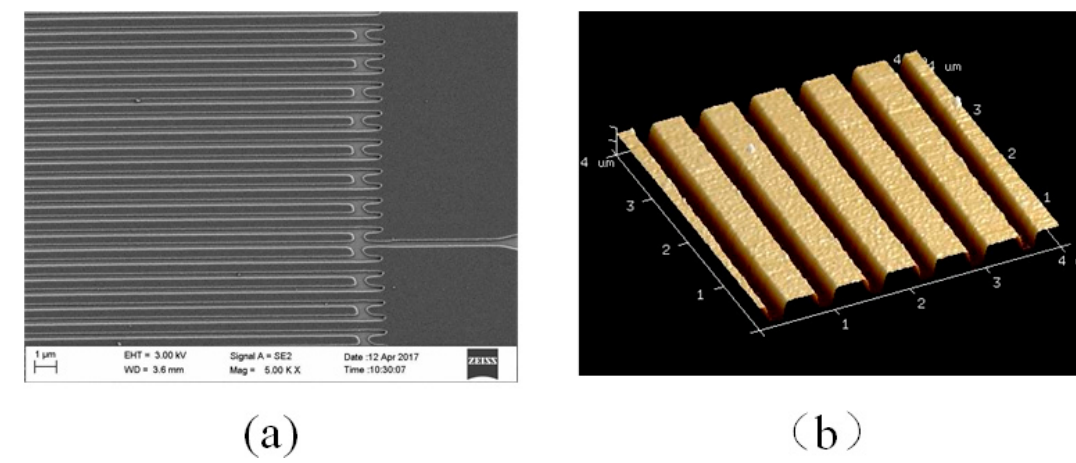
Figure 5. SEM ( a ) and AFM ( b ) characterisations of a section of the fabricated interdigital transducer (IDT).